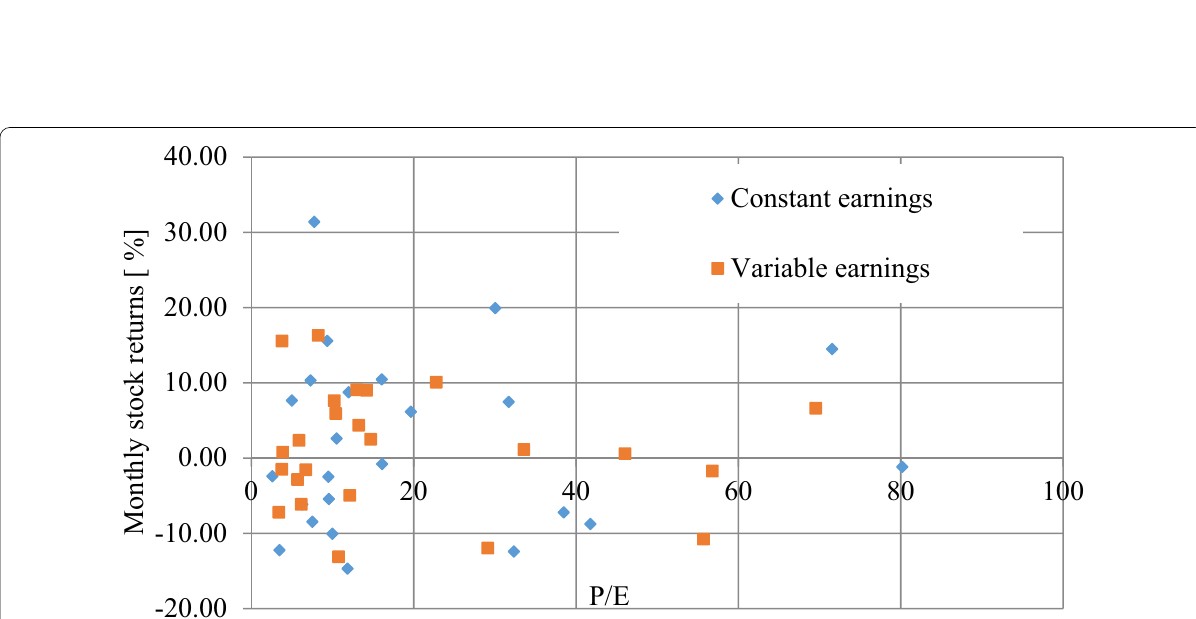
Fig. 20 Illustration of relative valuation metric P / E for stock B with constant and variable